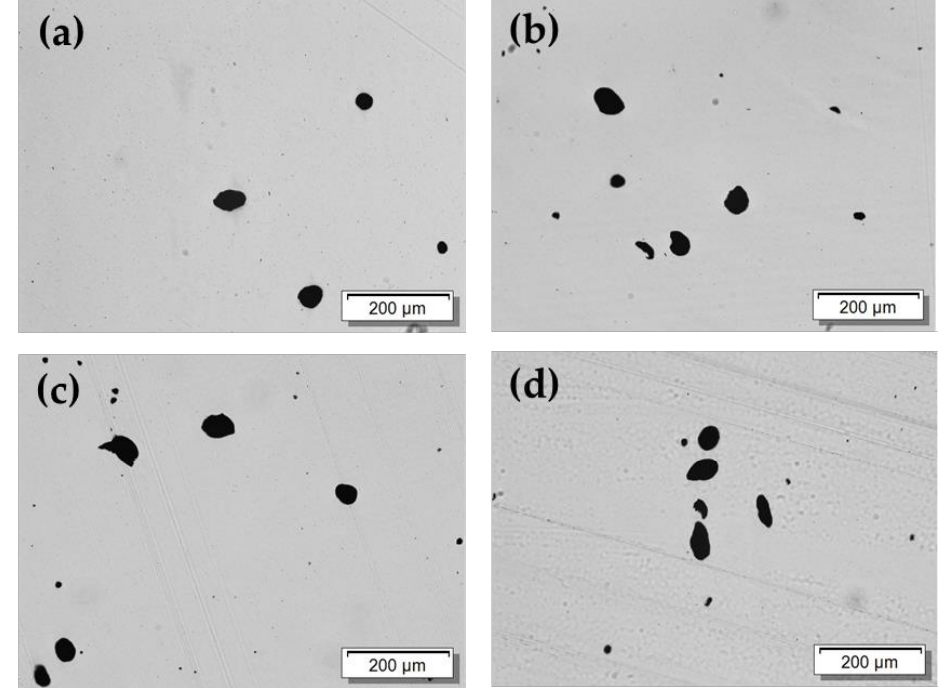
Figure 5. Characteristic light microscopy micrographs of PA66/PA6 blend composites with 1 wt % MWCNT having blend compositions of ( a ) 0/100; ( b ) 40/60; ( c ) 60/40; and ( d ) 100/0 wt %.